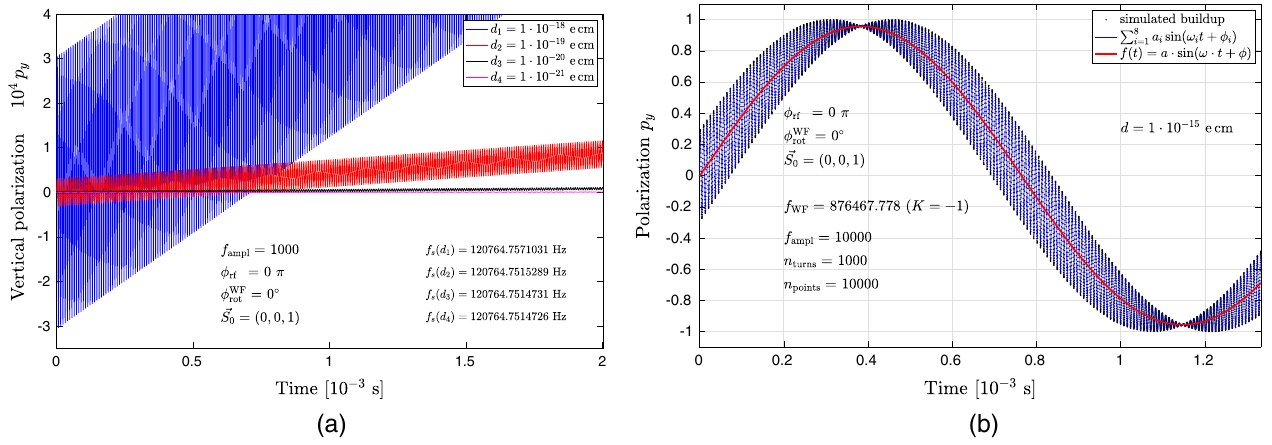
FIG. 12. Various EDM induced oscillation pattern for short [panel (a)] and long evolution times (b) using different amplification factors and values for the